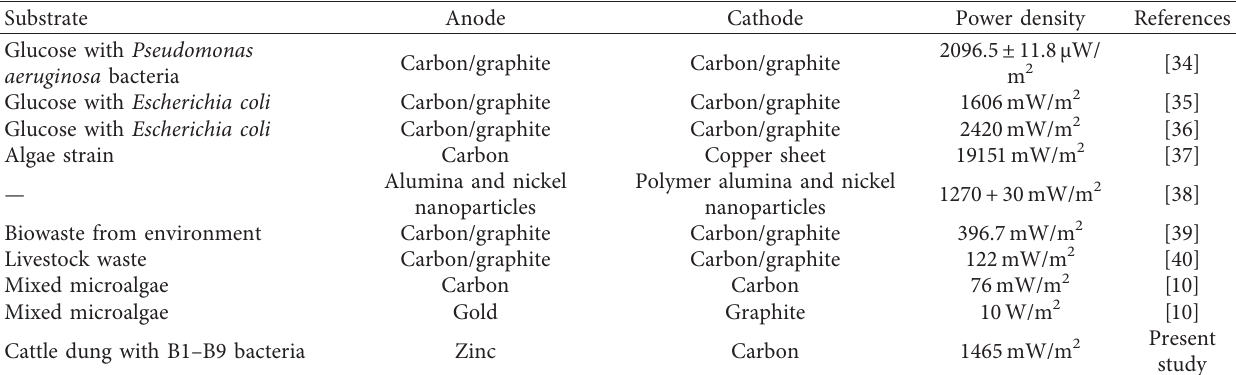
Table 5: Comparison analysis of various